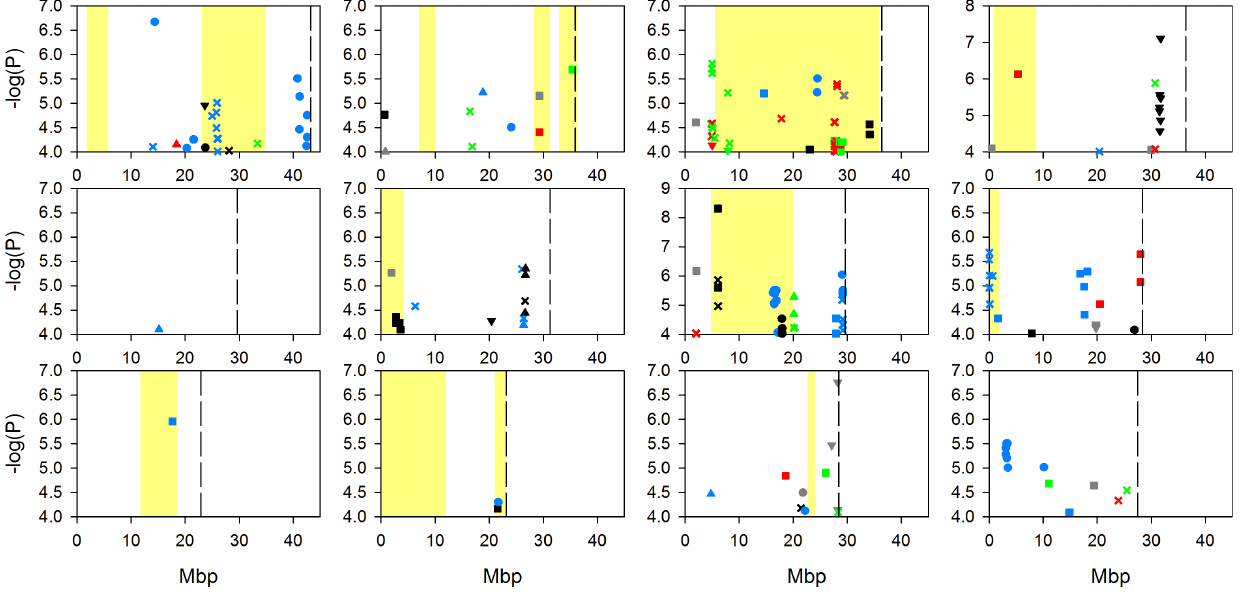
Figure 3. GWA mapping of molybdenum concentration at the five field sites across the 12 rice chromosomes. Data points represent SNPs significantly associated (p , 0.0001) with the trait and which have a MAF . 5%. Significant SNPs from different experiments are displayed with different coloured symbols: 2006 Arkansas are red, 2007 Arkansas are black, 2009 Texas are blue, Faridpur are green, and Qiyang are grey. Analyses of the combined subpopulation groups and separate subpopulations are represented by different symbols: combined analysi=Xs, aus =circle, indica =square, tropical japonica =triangle, temperate japonica =inverted triangle. Yellow highlighted bars indicate regions of mapped QTLs for grain molybdenum concentration (17, 21, 22). Dotted lines indicate chromosome ends.